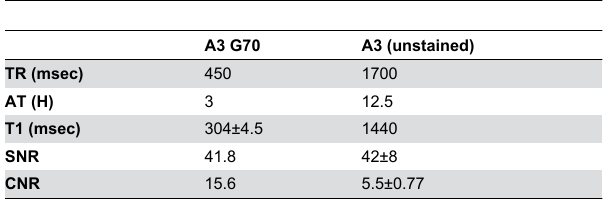
Table 2. MRI contrast agent